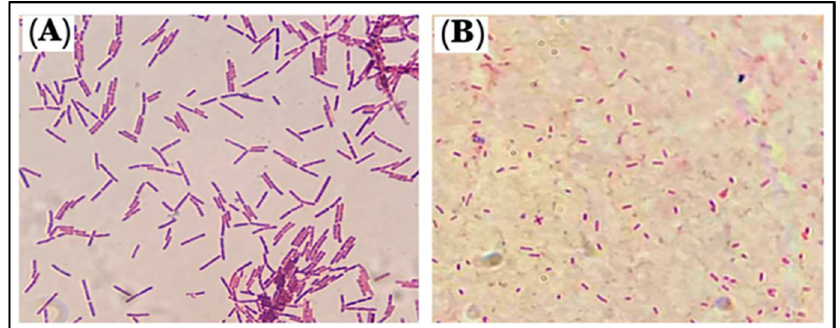
Figure 9. Morphology of the microbes: ( A ). B. cereus and ( B ). P. mirabilis .